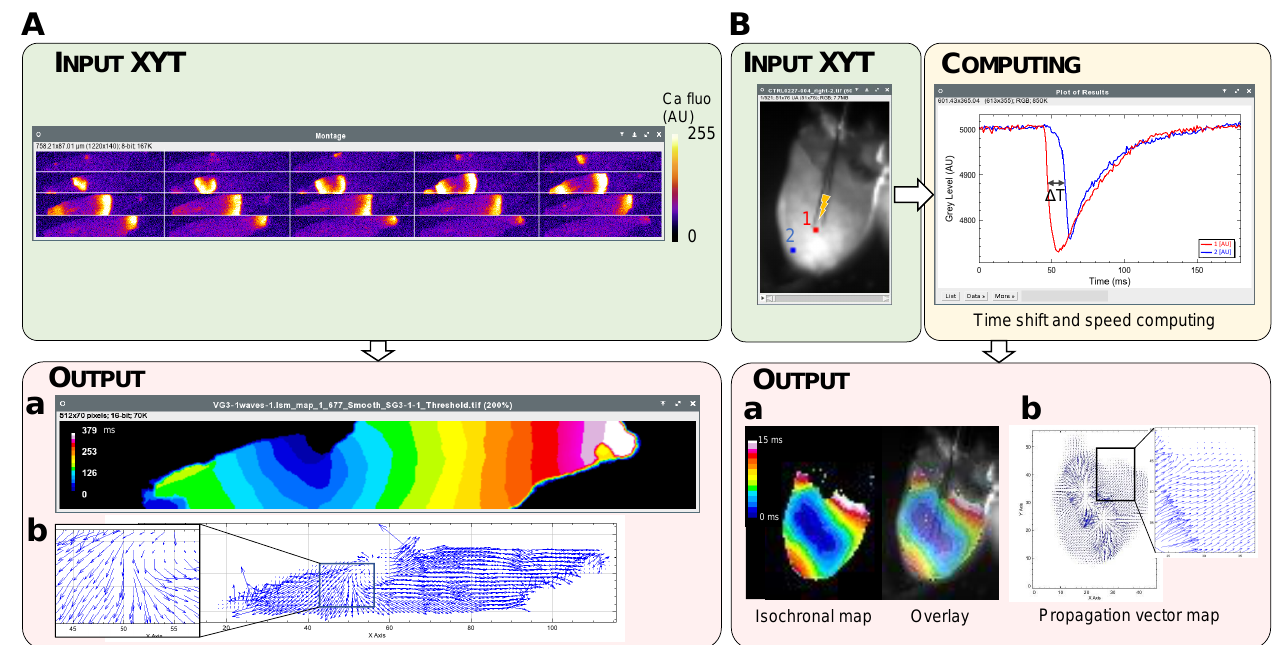
Figure 4. Examples of analysis of XYT data leading to isochronal ( a ) and vector ( b ) maps as outputs. ( A ) Propagation of a spontaneous calcium wave in an isolated cardiomyocyte. Input data is an image stack of the wave recorded by confocal fluorescence microscopy. The image sequence (left to right and top to bottom) shows a selection of images of the stack with a time interval of 20 ms. ( B ) The same heart as in Figure 3B is shown here. The isochronal map (Ba) can be overlaid on the original image.